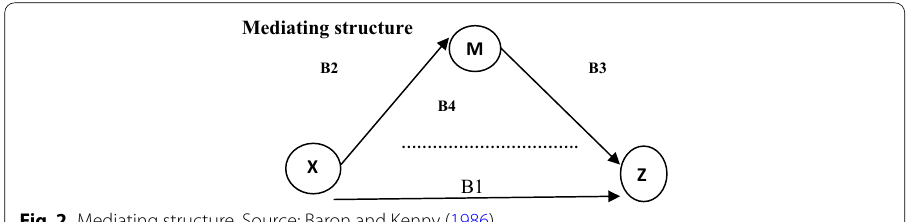
Fig. 2 Mediating structure. Source: Baron and Kenny